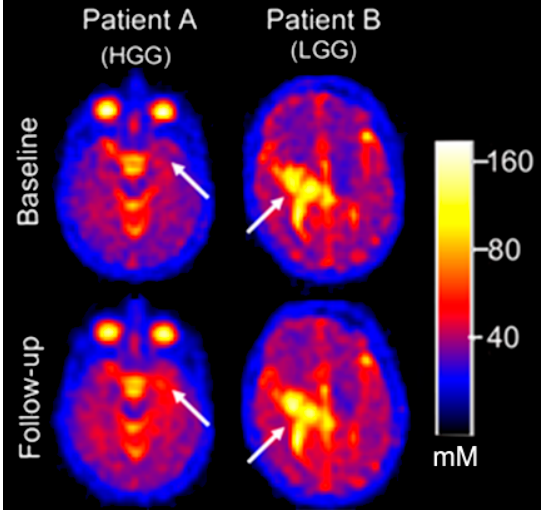
Figure 3. Initial ( top row ) and follow-up ( bottom row ) sodium MRI scans of supratentorial pediatric gliomas with ( A ) increased total sodium concentration (TSC) corresponding to tumor progression in a supratentorial high-grade glioma (arrows) (HGG), and ( B ) no change in TSC corresponding to a stable supratentorial low-grade glioma (arrows) (LGG).